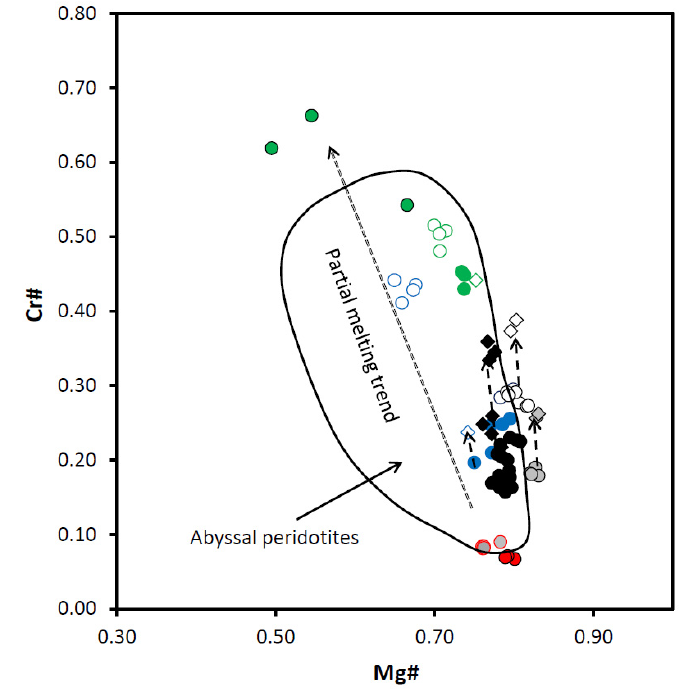
Figure 10. Diagram Mg# vs. Cr# for spinels from the East Antarctic peridotite xenoliths. Cr# = [Cr/(Cr + Al)] (at%); Mg# = [Mg/(Mg + Fe 2+ )] (at%); Field for Abyssal peridotites and the Partial melting trend are after [18,24]. Symbols are as in Figure 9.